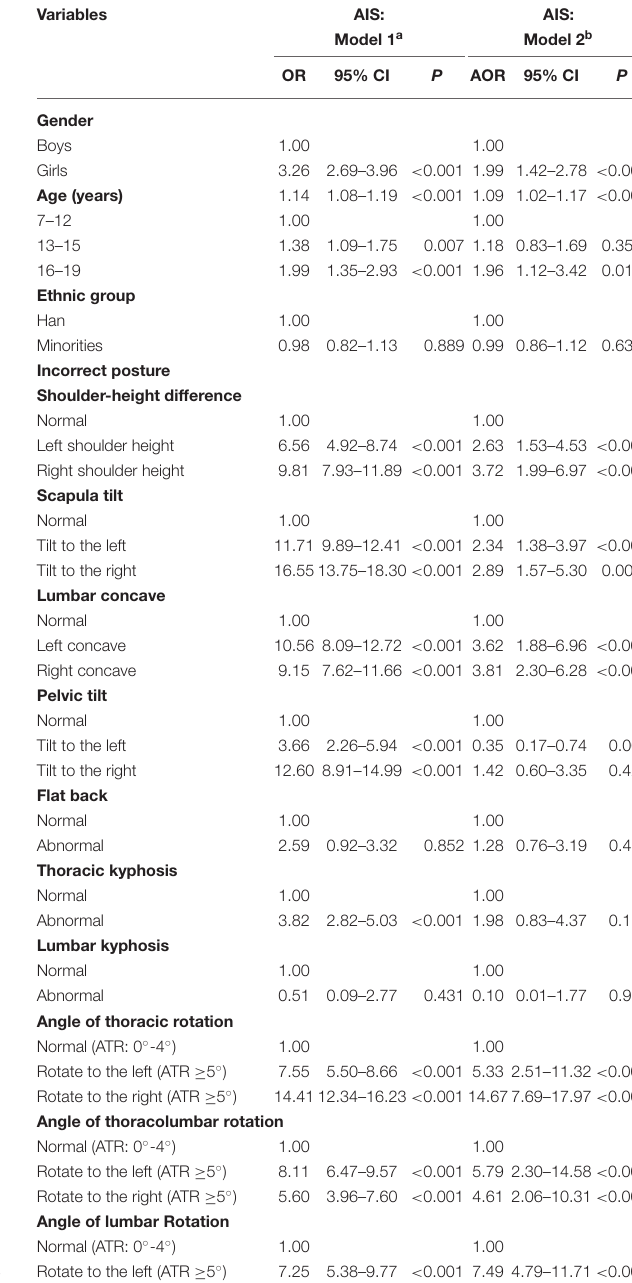
AIS, adolescent idiopathic scoliosis; OR, odds ratio; AOR, adjusted odds ratio; CI, confidence interval; ATR, angle of trunk rotation. a Univariate logistic regression model. b Multivariate logistic regression model.